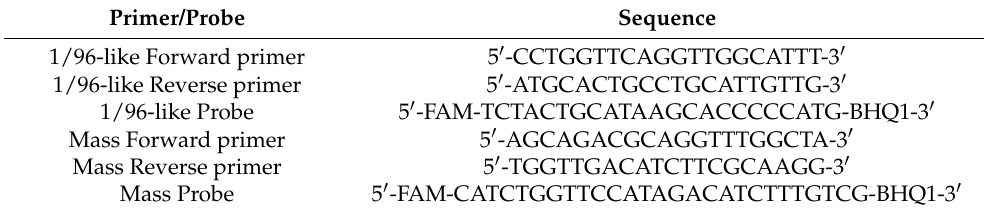
Table 1. Primers and probes implemented in the Mass and 1/96-like specific real time RT-PCR assays, previously designed by Tucciarone et al.